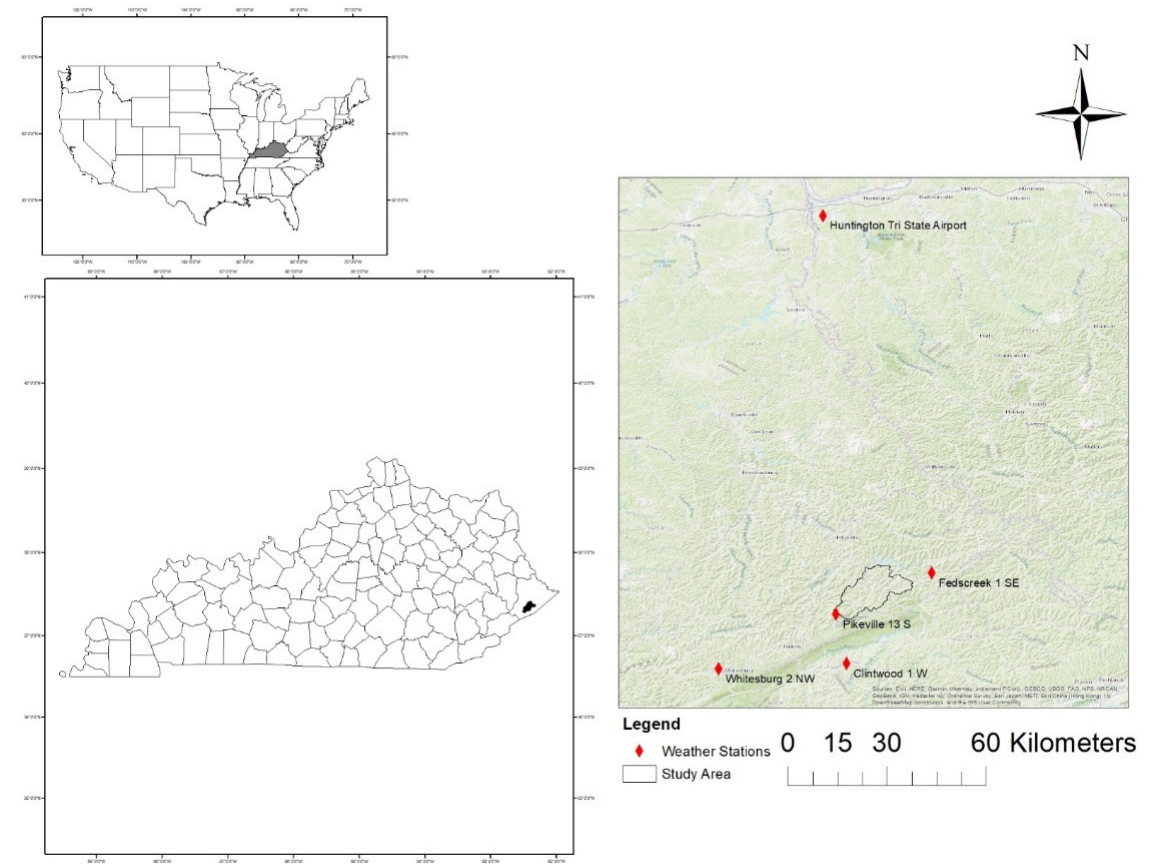
Figure 1. Study area showing watershed boundary and weather stations. Table 1. List of weather stations that provided monthly precipitation data for the project Organization